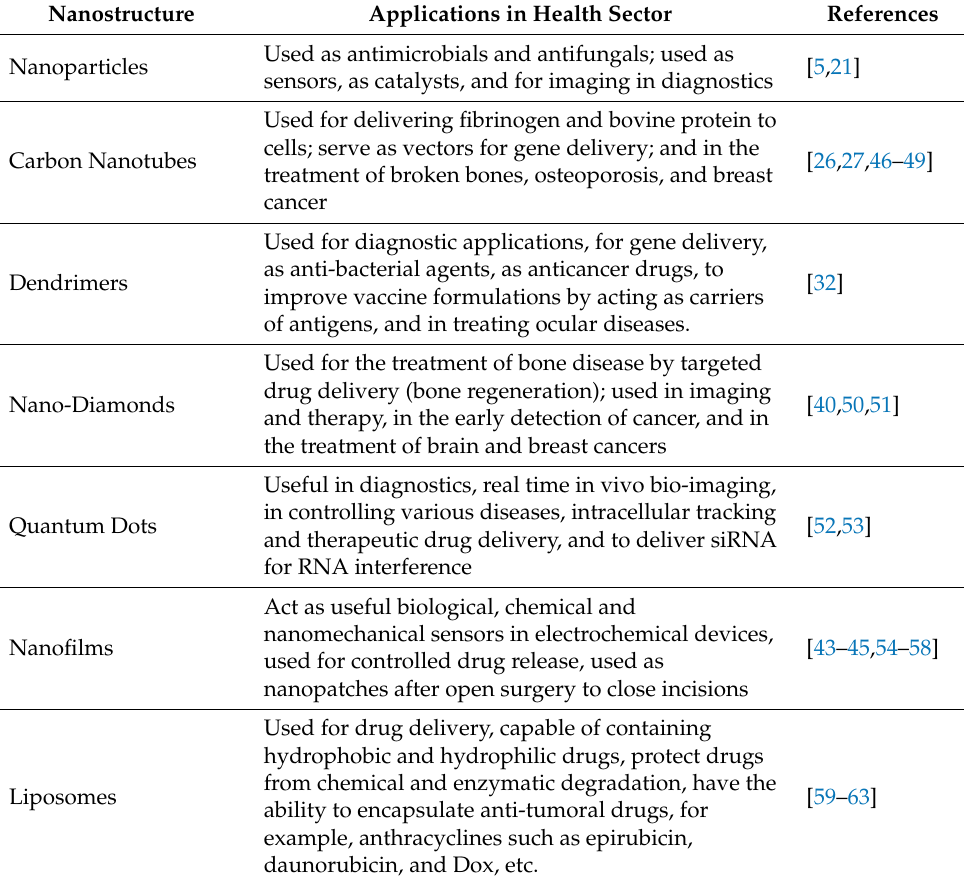
Table 1. Applications of various nanostructures in healthcare